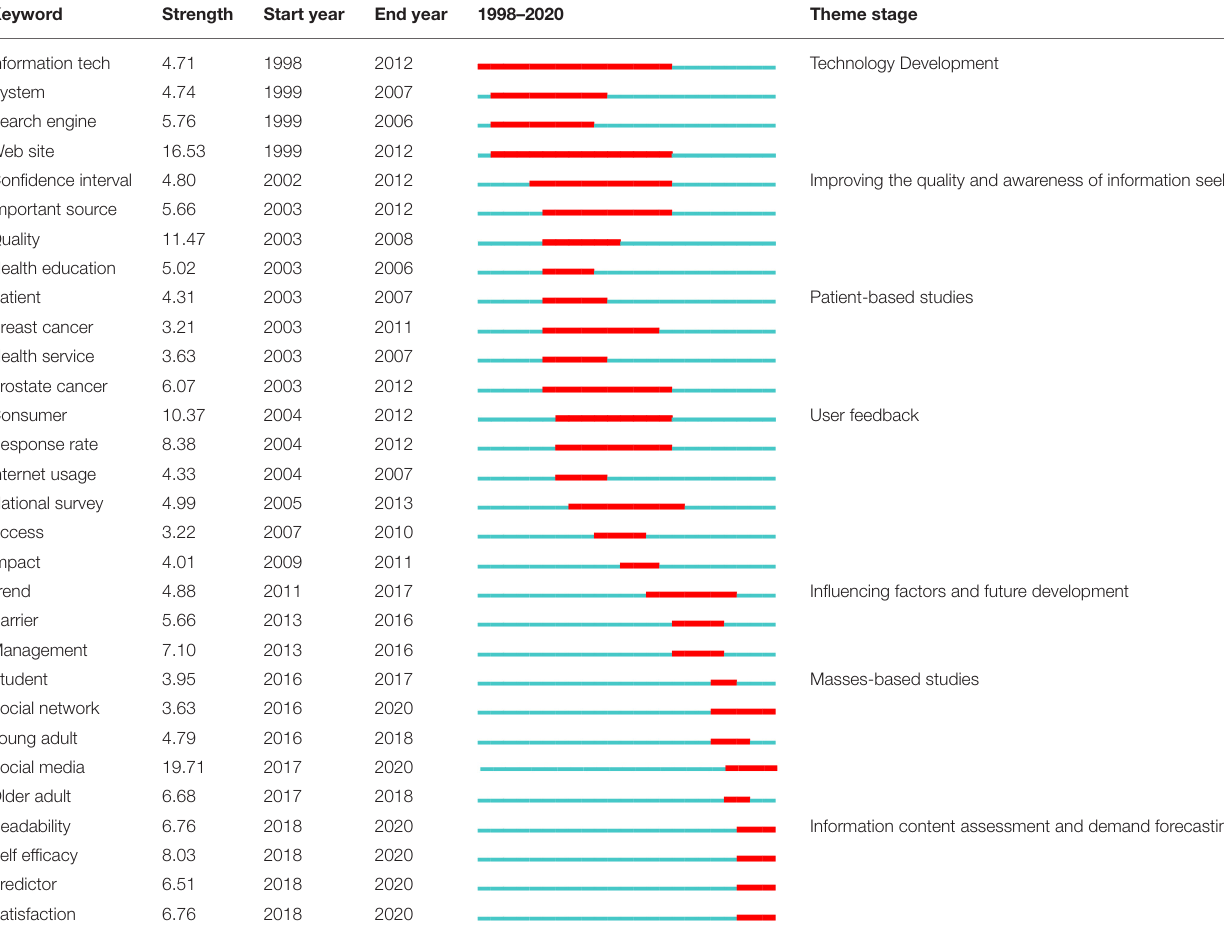
TABLE 2 | Keywords burstness in the study of online health information-seeking